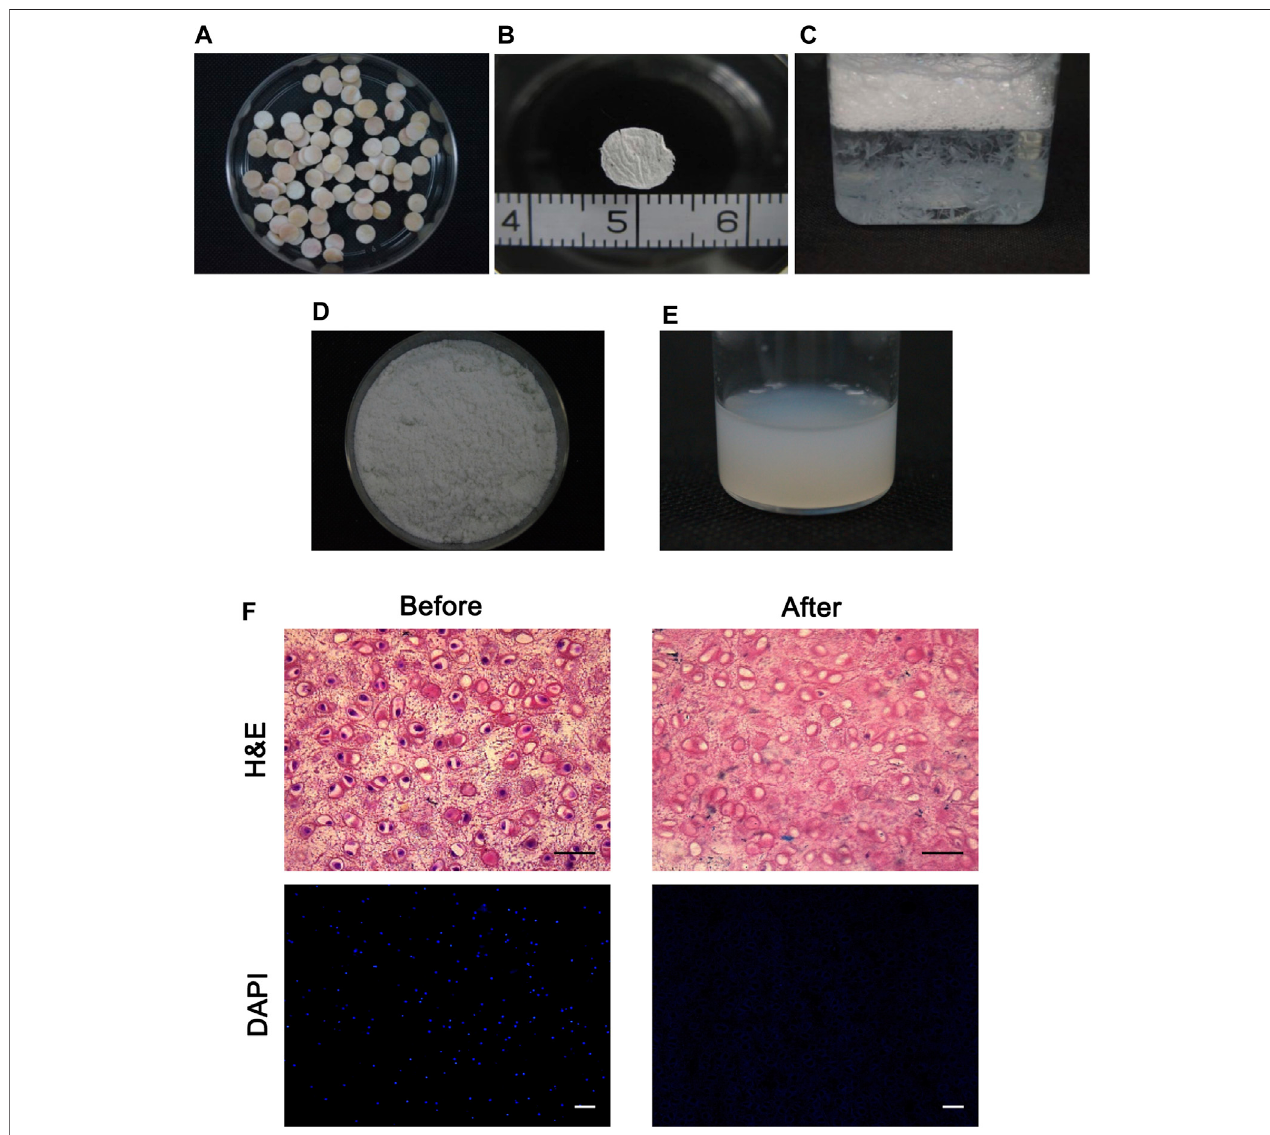
FIGURE 1 | Production of the decellularized cartilage extracellular matrix. (A) Macroscopic images of cylindrical cartilage slices. (B) 10-µm-thick cartilage sheets were observed. (C) Cartilage sheets were decellularized. (D, E) Decellularized cartilage sheets were lyophilized, milled into a fi ne, white powder (D) , and solubilized usingpepsinandHCl (E) . (F) Histologicalanalysesofthecartilageslicesbeforeandafterdecellularizationcon fi rmedtheabsenceofnucleiviaHEandDAPIstaining.Scale bars (cid:2) 50 µm.